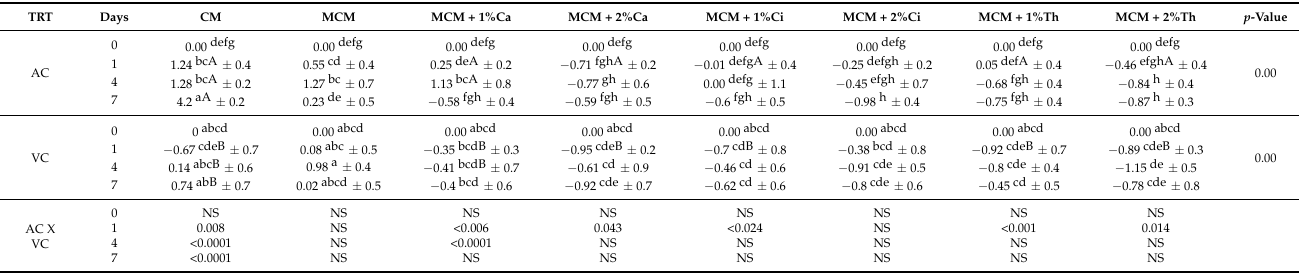
Table 3. Population changes of yeast and molds (log (N0/N) ± SD CFU/g) in marinated camel meat with essential oils under (AC) aerobic and (VC) vacuum conditions after storage at 4 ◦ C for 0, 1, 4 and 7 days. TRT